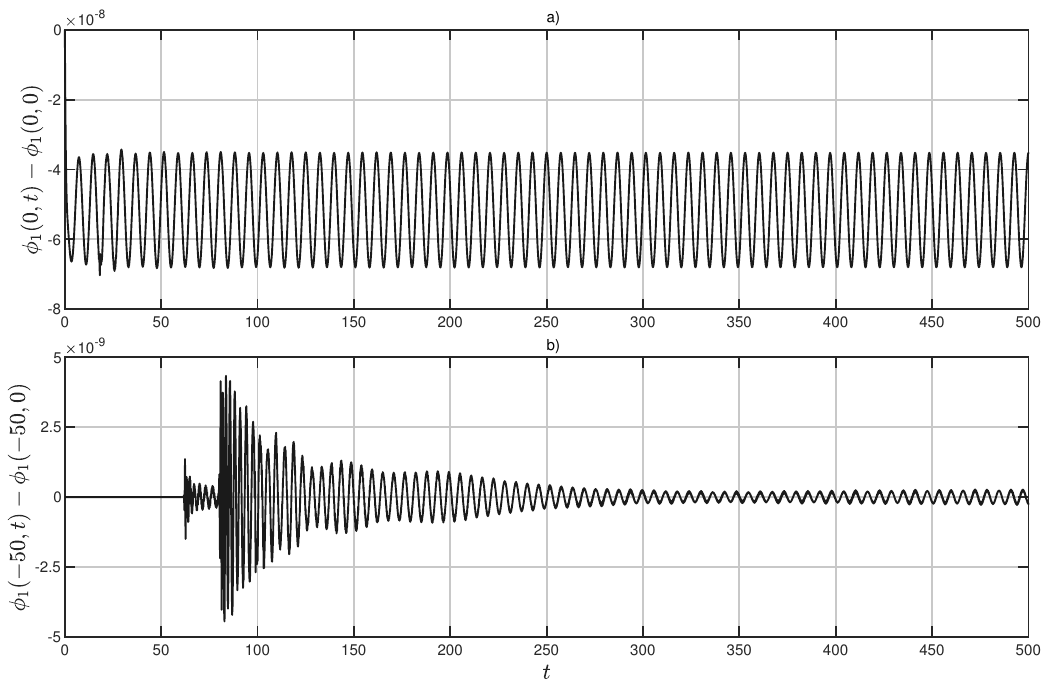
Figure 8 . Stability analysis of the numerical method, considering the φ 1 ( x ) configuration, com- patible with stability. a) the evolution of the field on the boundary, b) the field (radiation) away from the boundary at x = 50. For both figures H = 0 . 8 H m −